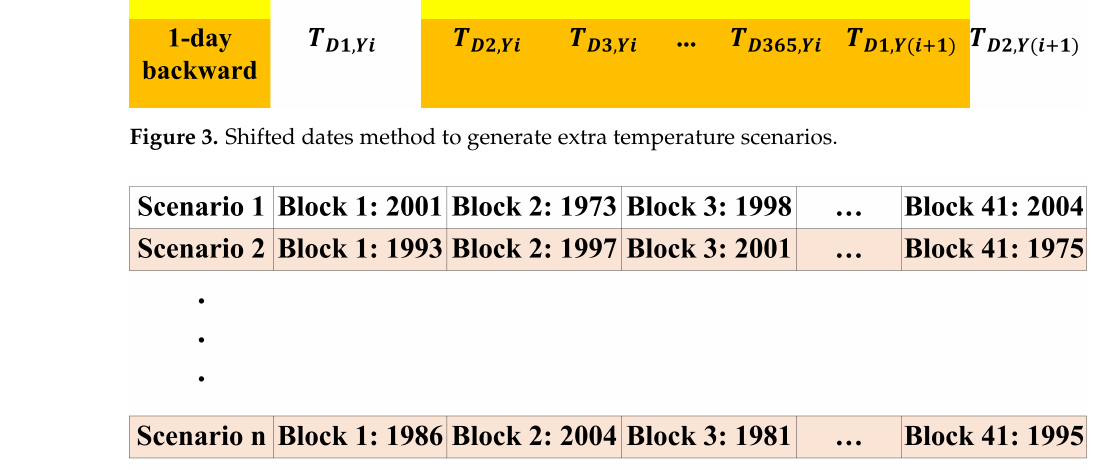
Figure 4. Bootstrapping method to generate extra temperature